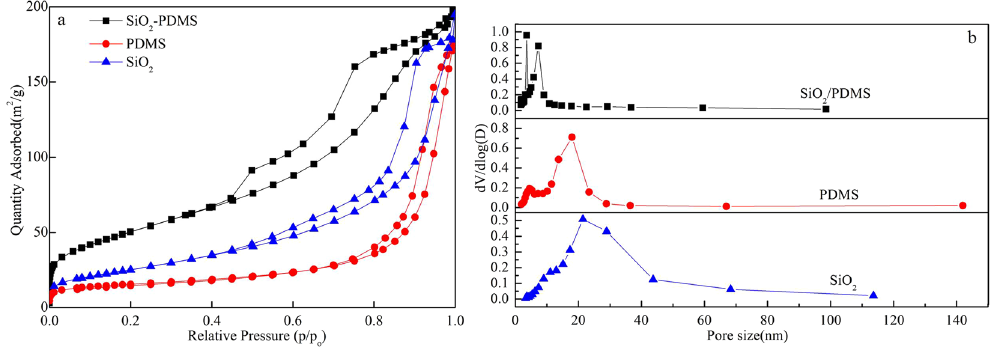
Figure 2. N 2 adsorption-desorption isotherms ( a ) and pore size distribution ( b ) of PDMS, SiO 2 and SiO 2 - PDMS.